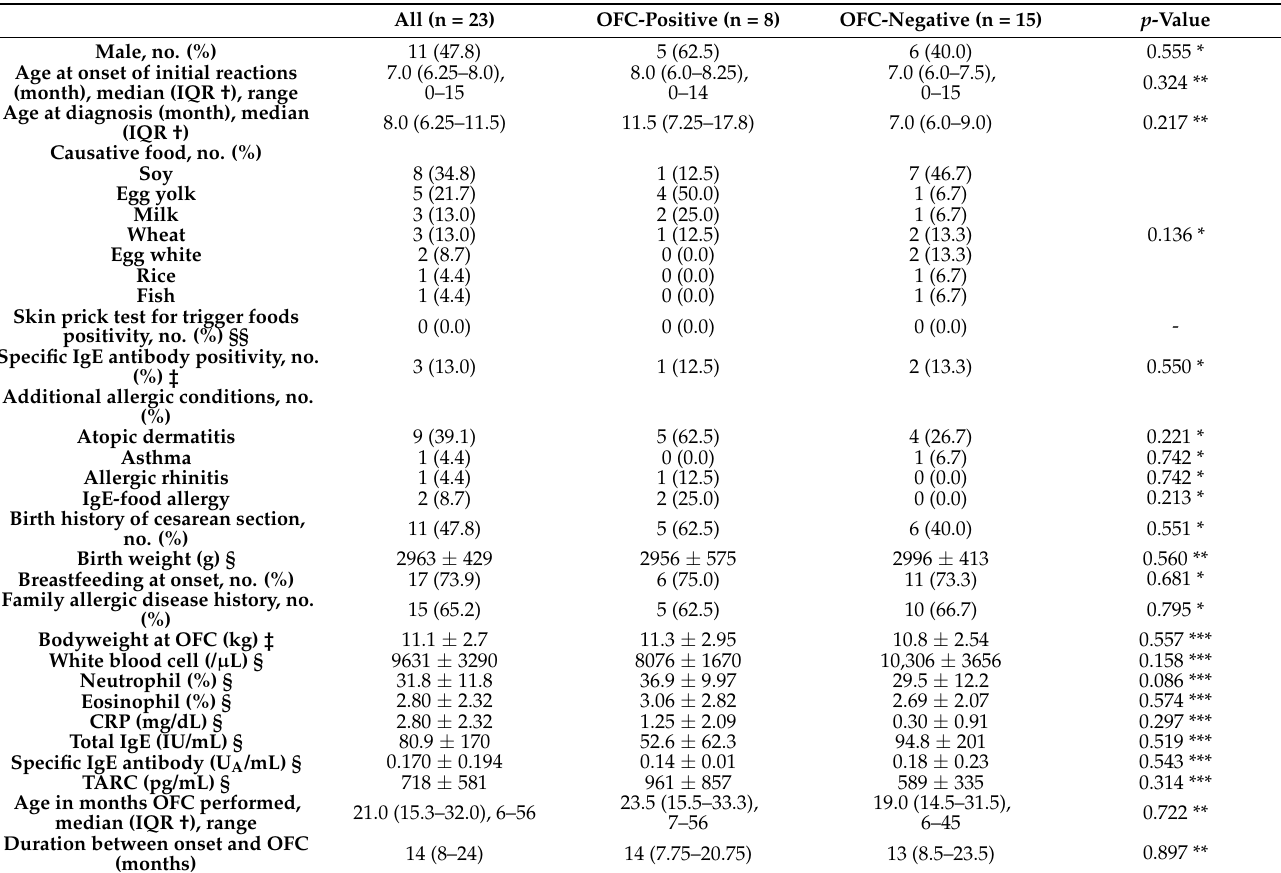
Table 2. Clinical characteristics of patients with acute FPIES and risk factor analysis with OFC outcomes.